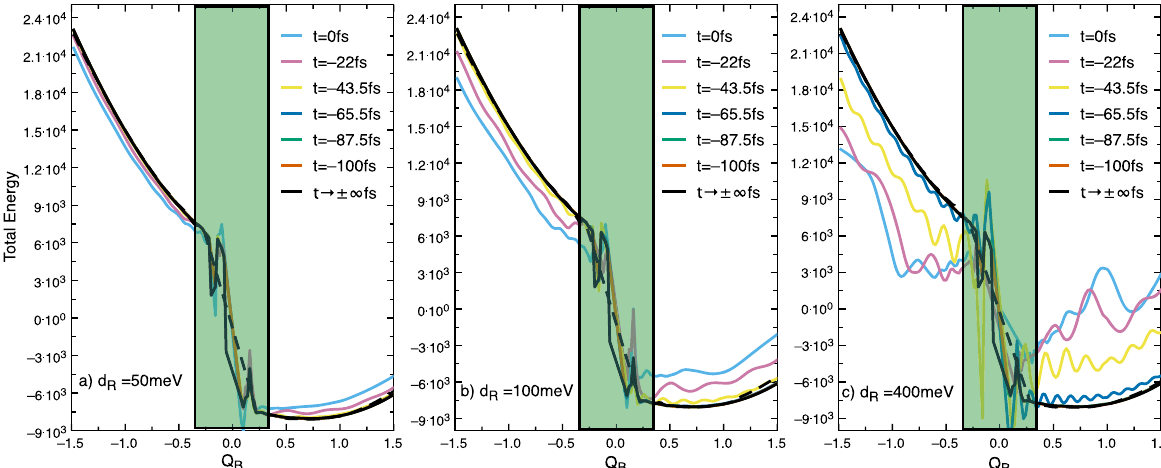
Fig. 3 Light-wave-driven phase transitions above electric fi eld threshold. The total energy landscape is shown as a function of lattice displacement Q B , obtained by using the calculated nonthermal populations and coherences at characteristic time instances during the oscillation cycles. We compare low ( a ), intermediate ( b ), and high ( c ) Rabi energies d R = eEa . The highlighted area around Q B ~ 0 indicates the parameter regime where the time propagation simulations are less accurate, due to the near degenerate energy levels between neighboring sites. For such a small Q B , band calculations 33 indicate a metallic behavior that is not realized in equilibrium. Furthermore, the multiple total energy local minima that develop in c for large Rabi energy d R indicate the nonequilibrium nature of the phase